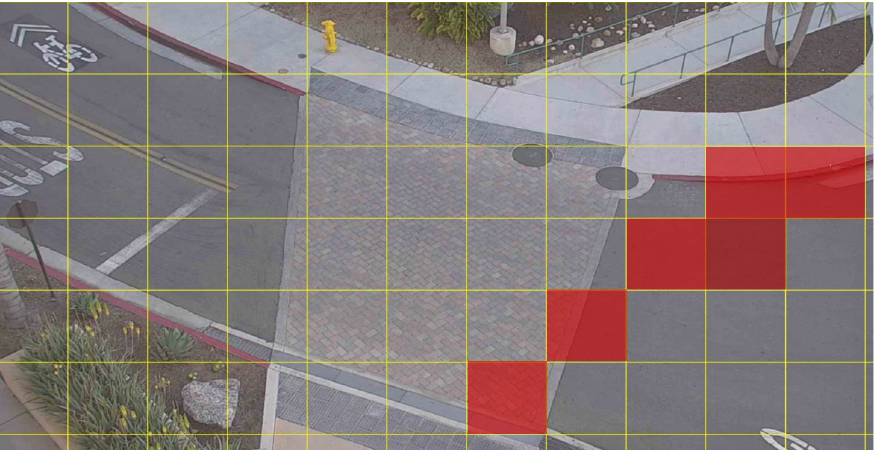
Figure 35. Conflict zones determined after streamline density analysis. For finer granularity and more robust hazardous region detection, the grids can be made